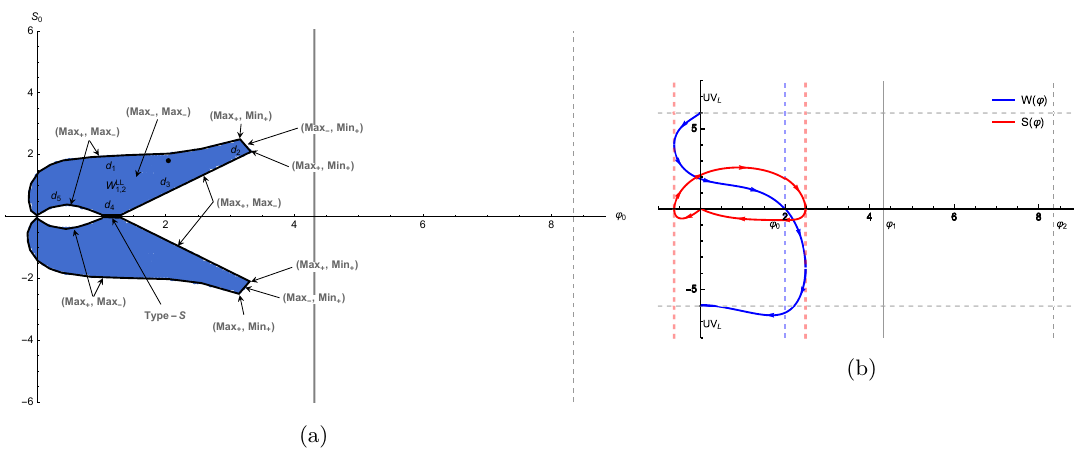
solutions is the upper blue region. The black dot represents Figure 23 . (a): the space of the W LL 1 , 2 the specific solutions of diagram (b). The lower blue region corresponds to the solutions with an extra ϕ -bounce near the bottom UV . (b): the blue and red curves for W, S , describe a flow that L connects the UV fixed point to itself but after two ϕ -bounces. The locations of the ϕ -bounces are L indicated by red dashed lines.